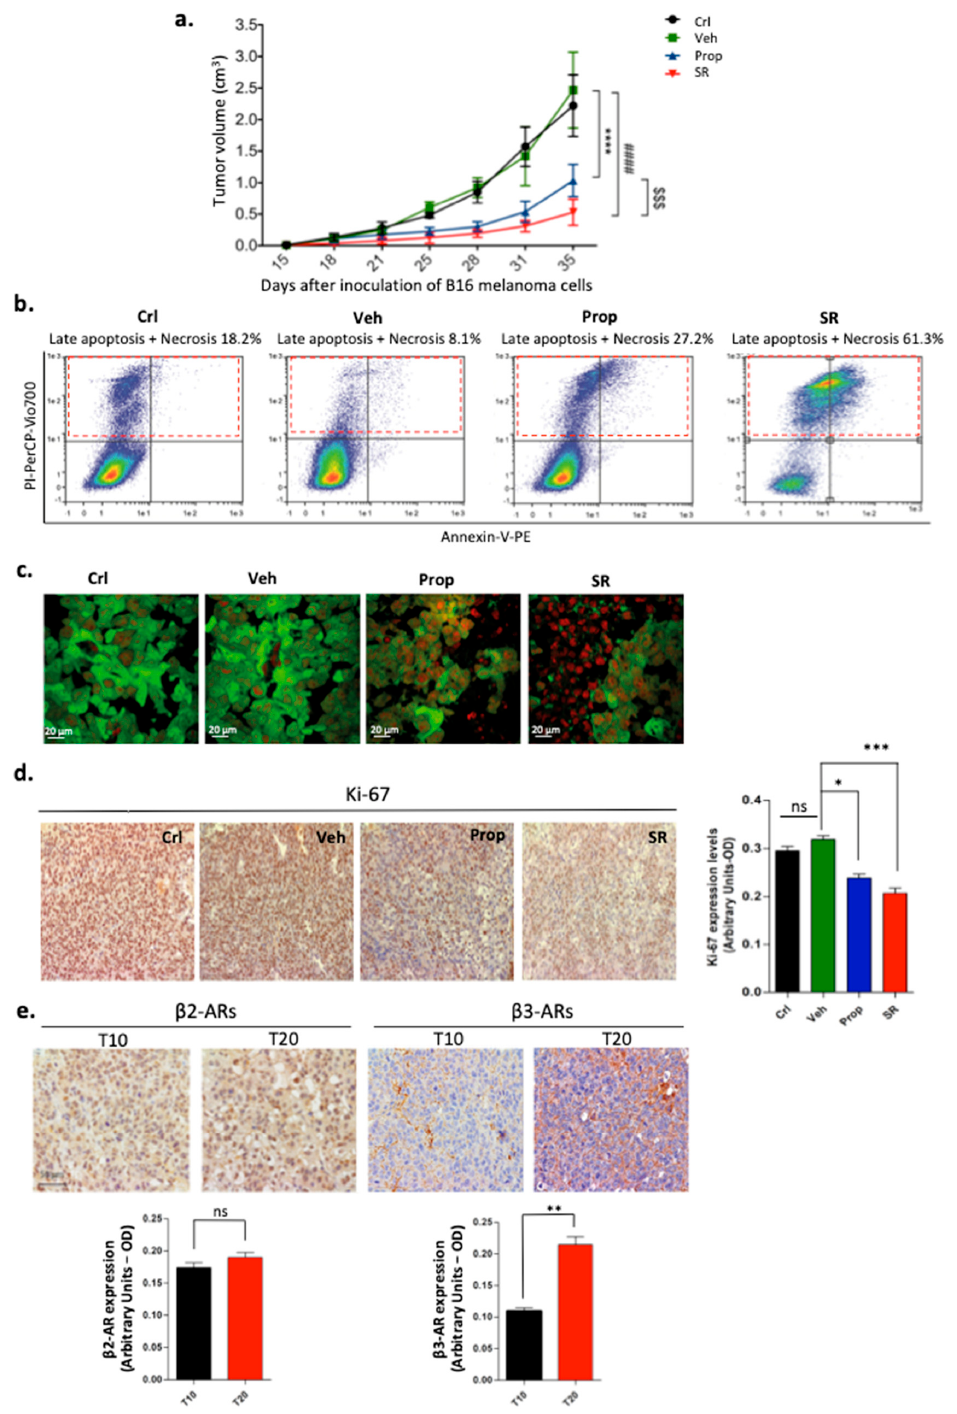
Figure 1. ( a ) Tumor growth rate after the subcutaneous injection of B16-F10 cells in control (Crl), vehicle-(Veh), propranolol-(Prop), or SR59230A-(SR) treated C57BL / 6 mice (n = 6). Values are presented as mean ± SD. ( b ) Representative Annexin V / PI staining plots of homogenized tumor samples after 20 days of treatment (T20). ( c ) Confocal microscopy images of PI staining of tumors obtained from mice injected with B16-F10-GFP. ( d ) Representative immunohistochemical staining of proliferation marker Ki-67 in tumor tissues after 20 days of treatment (T20), and relative quantification. ( e ) Representative immunohistochemical staining of β 2- and β 3-ARs in tumor tissues, and relative quantification after 10 days (T10) and 20 days (T20) of treatment. ns = not significant; β 2-Ars = β 2-Adrenoreceptors; β 3-ARs = β